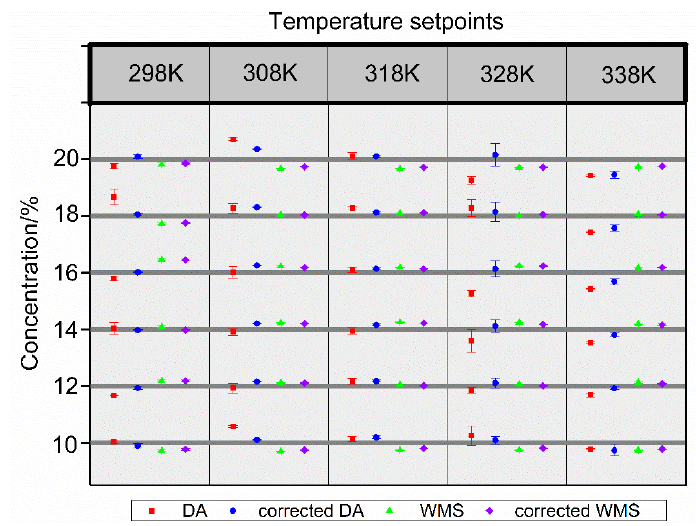
Figure 13. Measured concentration of all four measurements at temperatures 298–338 K and concentrations 10–20%.